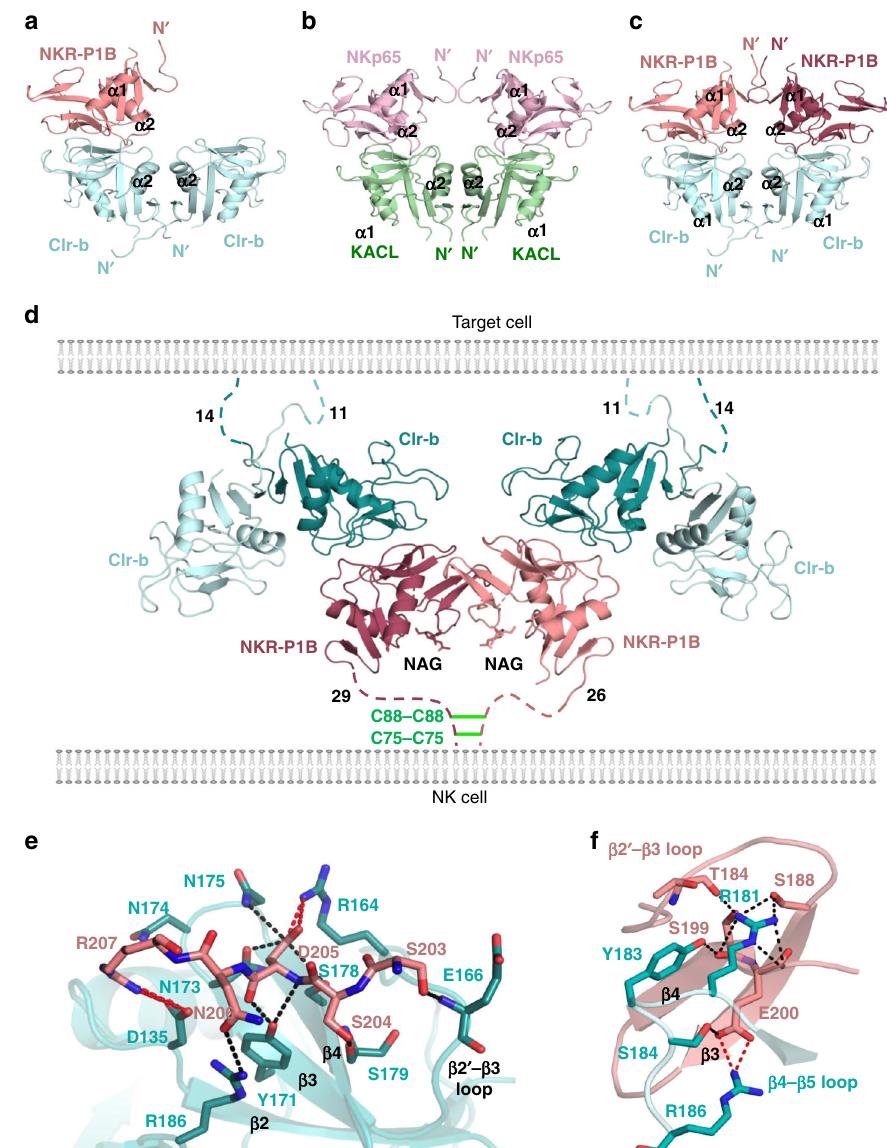
Fig. 3 Overview of the NKR-P1B:Clr-b complex. a Simpli fi ed representation showing how a single NKR-P1B monomer engages one half of the Clr-b homodimer in a 1:2 receptor-ligand stoichiometry. b Structure of the related NKp65 receptor bound to KACL (PDB ID: 4IOP) where two NKp65 monomers bind to the KACL homodimer. c Model of a fully saturated 2 NKR-P1B: 2 Clr-b complex. d Representation of the hexameric NKR-P1B:Clr-b assembly visible within the crystal structure, and how it could be accommodated at the NK cell-target cell interface. Membrane proximal stalks not visible within the crystal structure are depicted as dashed lines, with their length annotated. The position of inter-molecular cysteines in the NKR-P1B stalk are shown as green lines. e , f Close up views of the interactions at site I ( e ) and site II ( f ) within the NKR-P1B:Clr-b interface. Hydrogen bonds (black) and salt-bridges (red) are shown as dotted